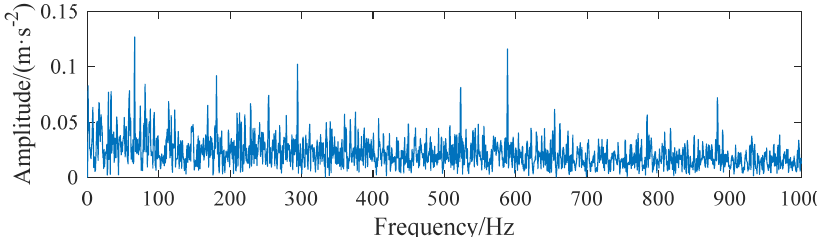
Figure 13. Envelope spectrum of the 2056th set of data.